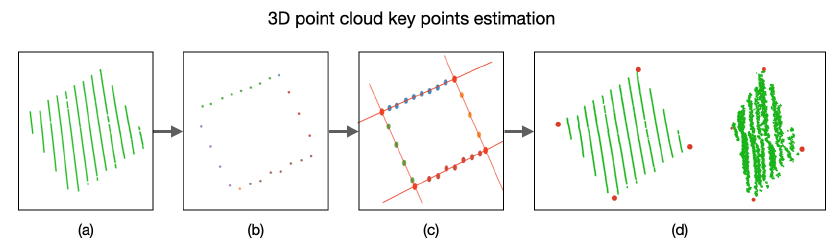
Figure 16. Key points estimation in a 3D point cloud. (a) Point cloud of the calibration board. (b) Extraction of points belonging to the edges of the calibration board. (c) Edge lines intersection and estimated key points. (d) Projection of the key points into the 3D space.